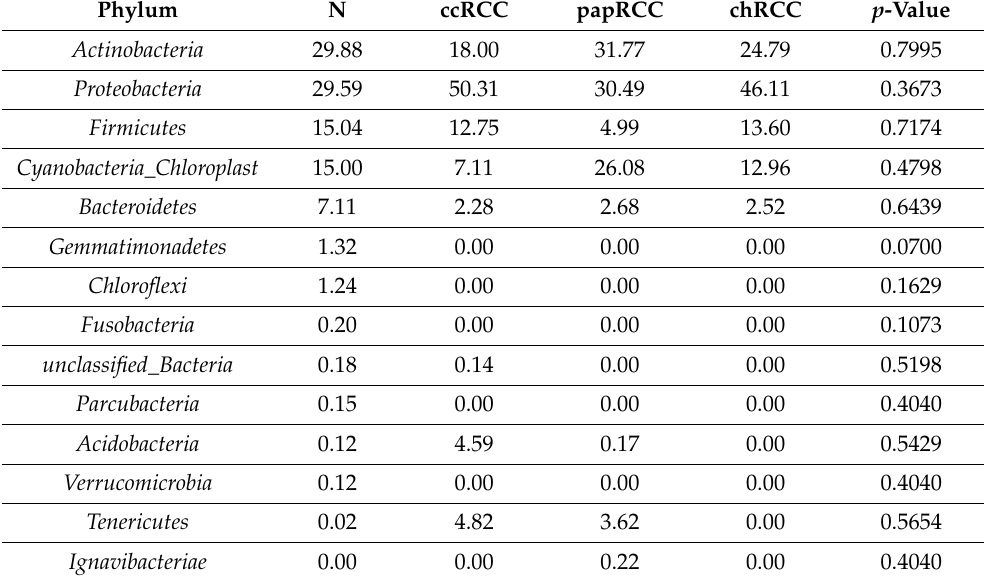
Table 2. Taxonomic composition of kidney tumors at the level of